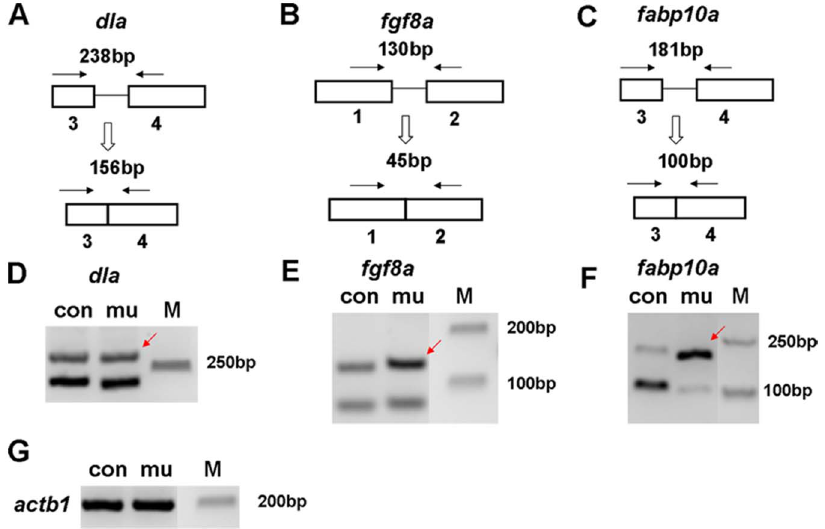
Figure 7. Pre-mRNA splicing of selected genes in dg5 mutant. (A–C) Schematic illustration of pre-mRNA splicing analysis of dla , fgf8 and fabp10a (arrows: primers; boxes: exons; lines: introns). (D–F) Splicing status of dla , fgf8 and fabp10a by RT-PCR using primers indicated in A–C. (G) actb1 is a loading control in each group.